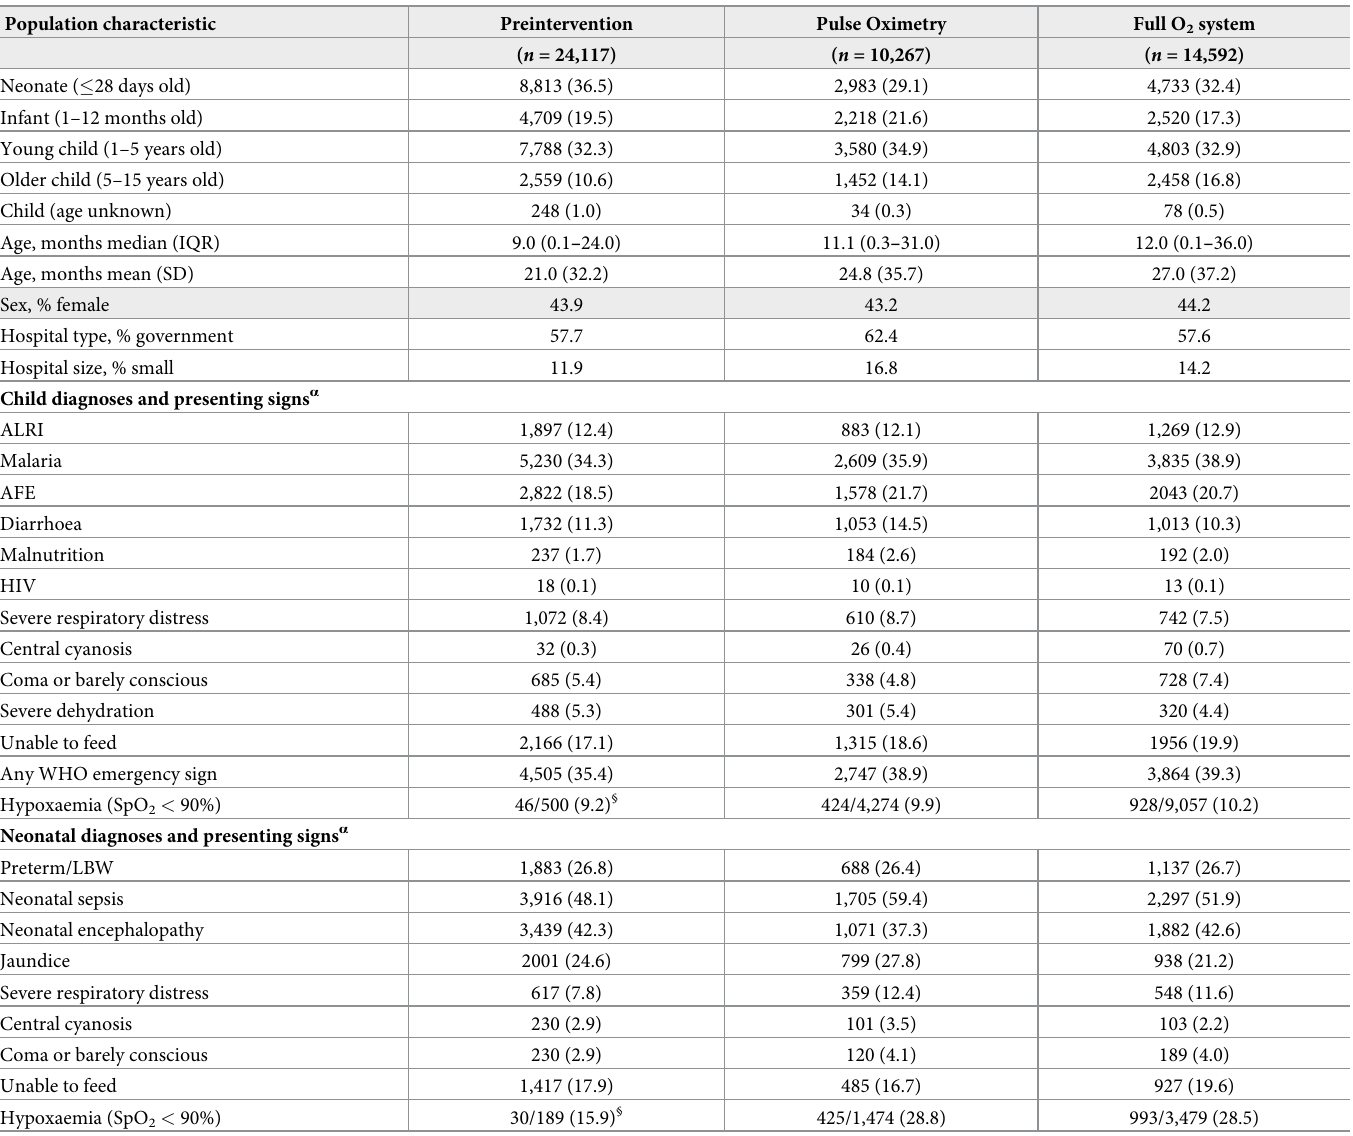
Table 1. Population characteristics, by study